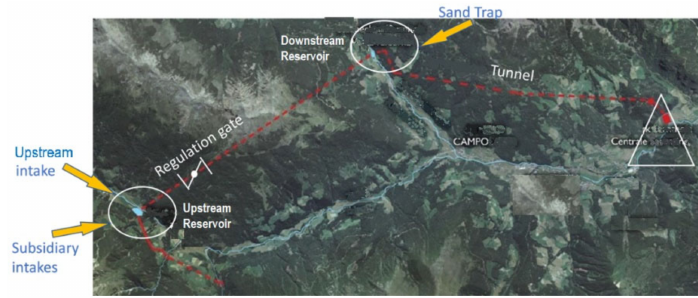
Figure 1. Top view of the plant